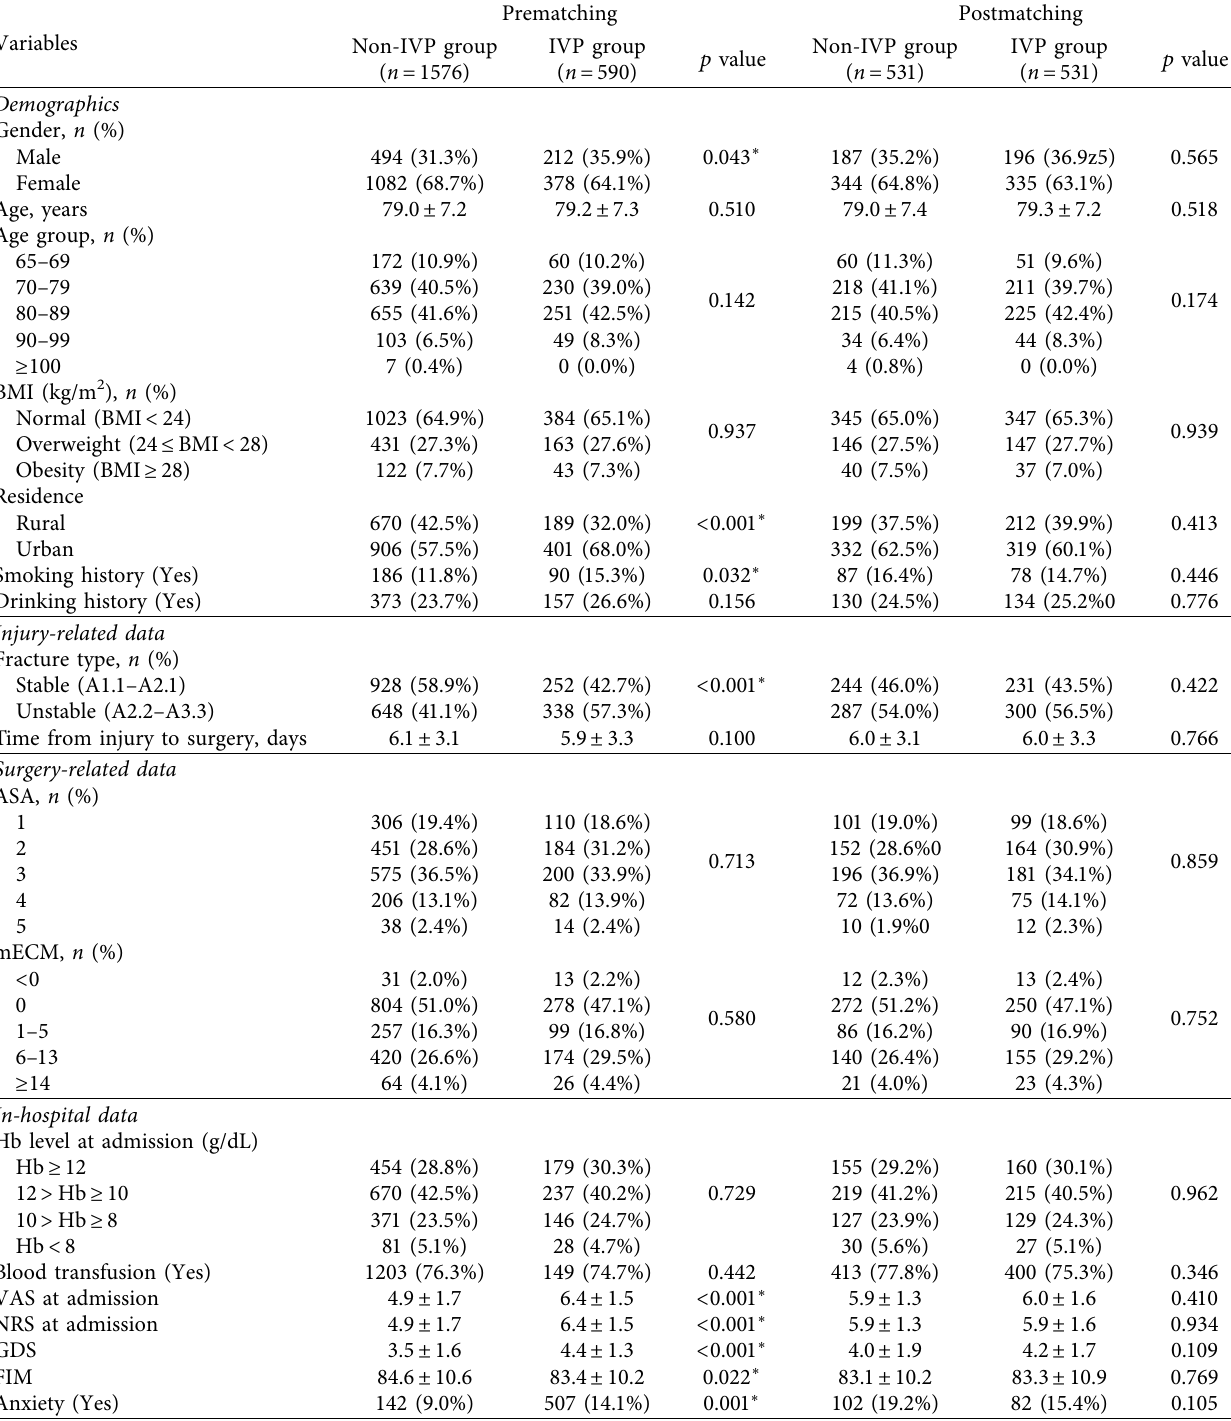
Table 1: Patient characteristics at baseline comparisons before and after propensity score